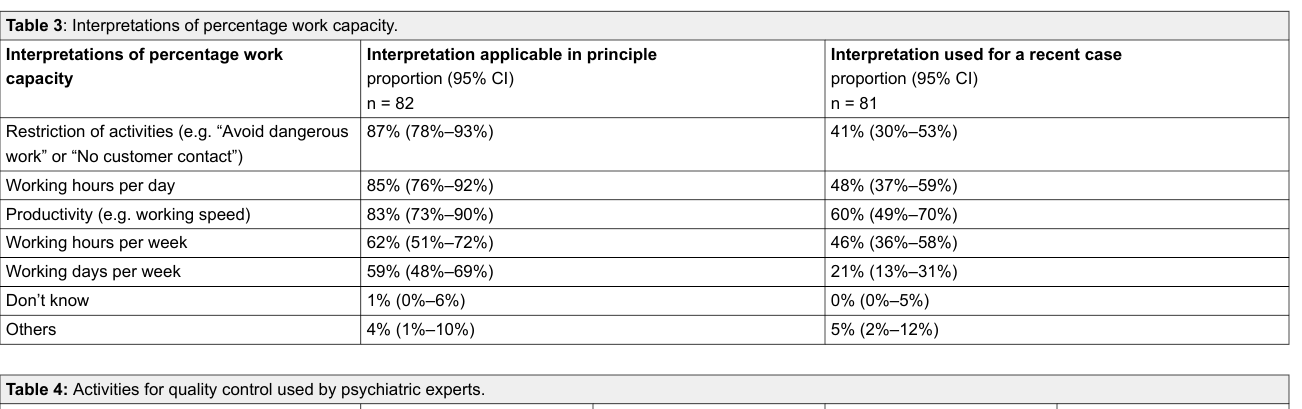
Table 3 : Interpretations of percentage work capacity.